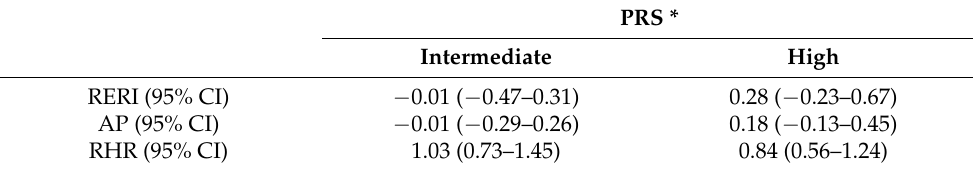
Table 3. Interaction between diet and genetic risk 1 .